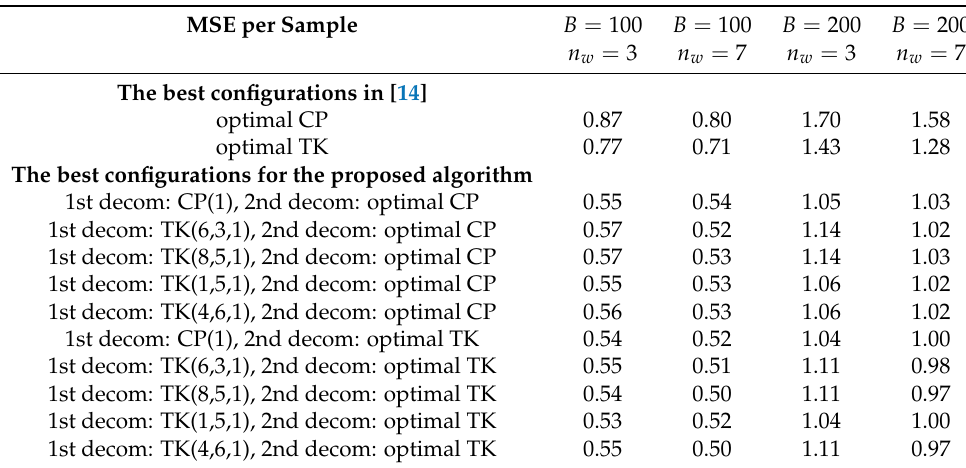
Table 1. MSE of the different tested methods. The results of 100 and 200 lost samples, B , are shown working with a 3 and 7 weeks of tensor size, n w . “The best configurations in [14]” show the minimum MSE obtained for the algorithm presented in [14], with the CP and the Tucker models. “The best configurations for the proposed algorithm” show the minimum MSE obtained for different pairs of decompositions. In these cases, only the core of the first decomposition is fixed, and it is shown the minimum MSE obtained with the best core for the second decomposition. MSE per Sample B = 100